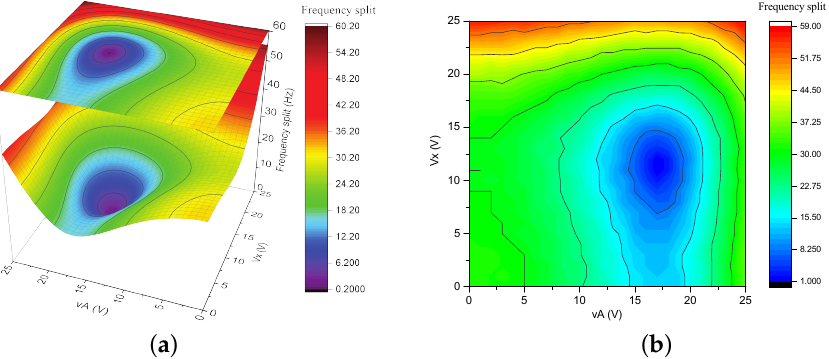
Figure 11. Frequency split of the non-ideal MRR under control of different V x and v A . ( a ) Analytical result. ( b ) Finite element method (FEM)